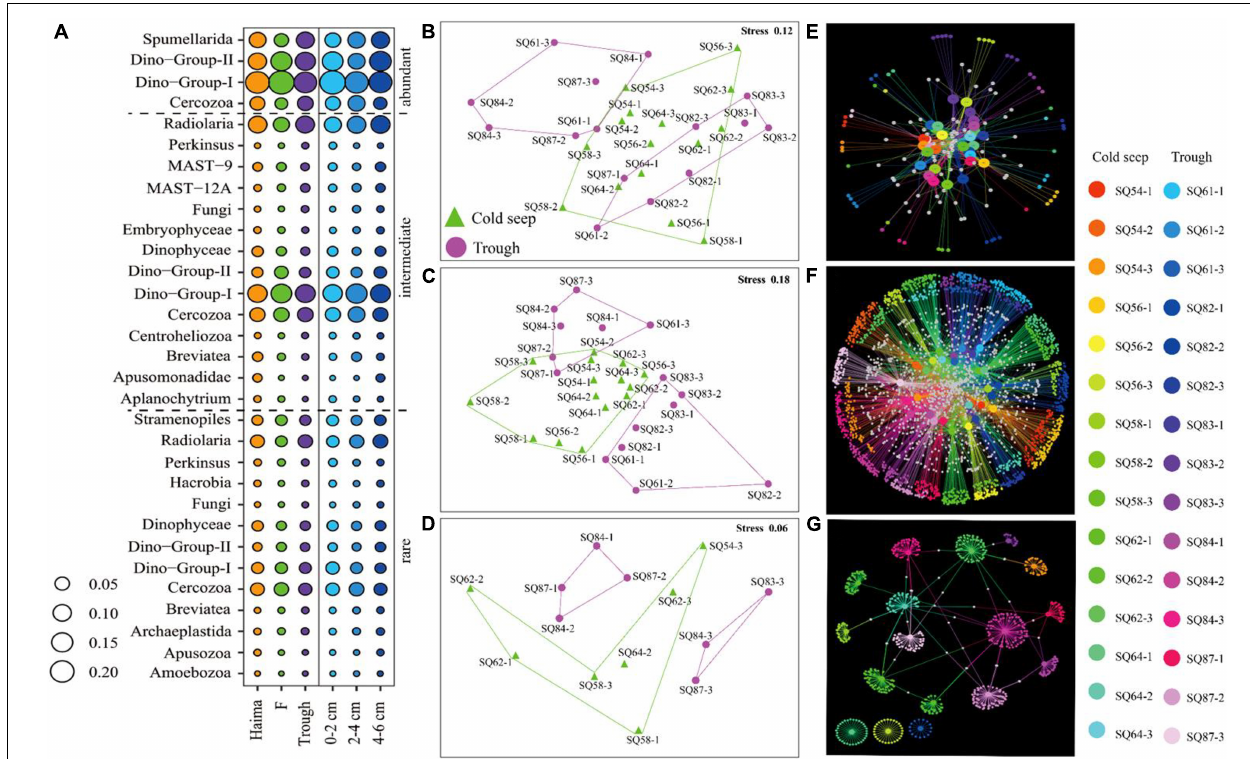
FIGURE 5 | Community structure (A) and nMDS plots (B–D) based on the relative abundance of the respective abundant (B) , intermediate (C) and rare (D) OTU categories. The size of bubbles reflects the proportion of each taxon. Network diagrams (E–G) based on the relative abundance of the respective abundant (E) , intermediate (F) and rare OTUs (G) ; the large nodes represent the samples, and the small nodes represent the OTUs. The white notes represent OTUs that were shared between samples. In (B–G) , the numbers 1, 2, and 3 represent the 0–2, 2–4, and 4–6 cm sediment layers,